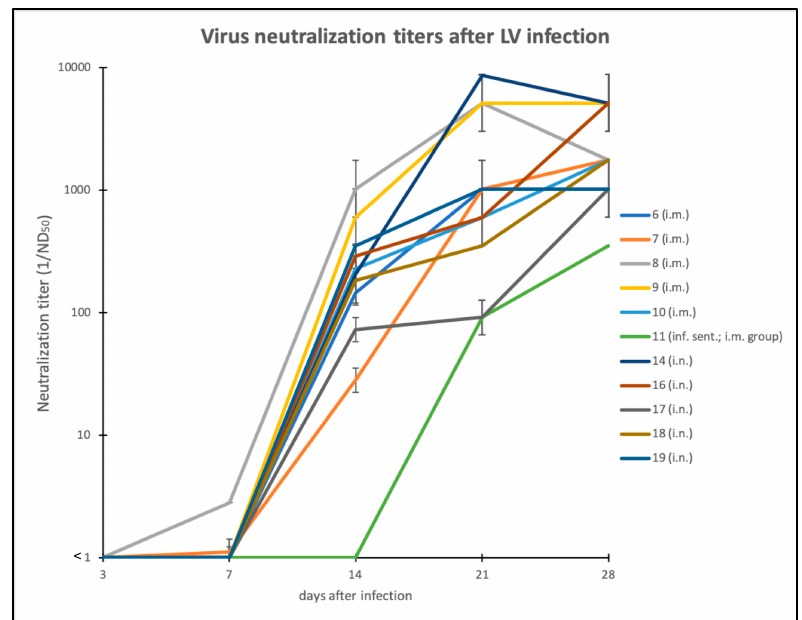
Figure 4. Virus neutralization activities of LINDA immune sera. The serum samples taken on study days 0, 3, 7, 14, 21 and 28 / 29 were tested in VNAs against LINDA. All VNAs were performed in triplicate and ND 50 was calculated using the Spearman-Kaerber algorithm. The reciprocal ND 50 value is presented for each serum sample including error bars for positive and negative standard deviation. All 1 / ND 50 values were less than 1 until study day 7, when the first weak neutralizing activities were measured in single animals. Significant neutralizing activities (ND 50 > 1:10) were detected in all infected animals starting on day 14. Note the later onset of humoral immune response in the infected sentinel animal from the i.m. group on day 21.